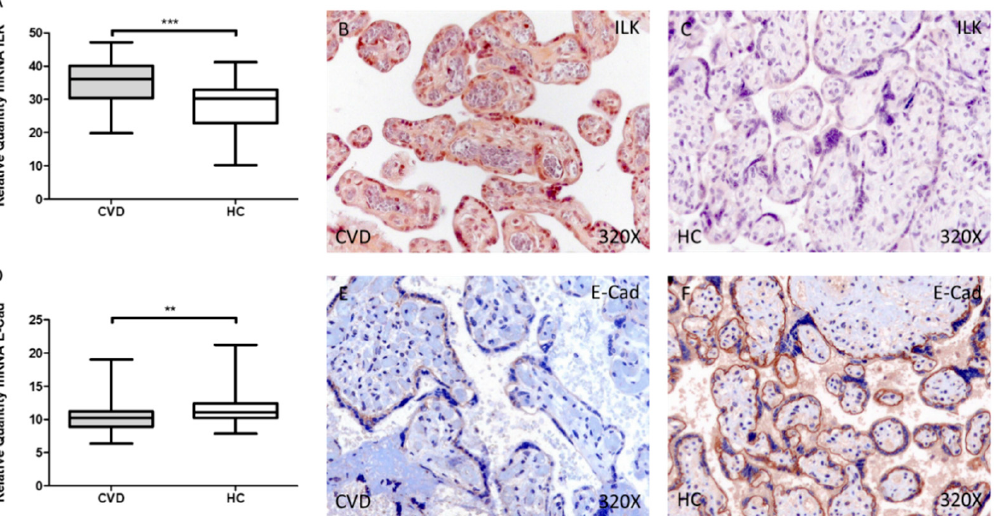
Figure 1. Levels of mRNA for ILK ( A ) and E-Cad ( D ) quantified by RT-qPCR, and histological imágenes for immunohistochemical techniques in the placental villi in of women with CVD during pregnancy and HC for ILK ( B , C ) and E-Cad ( E , F ). CVD = Chronic venous disease, HC = Healthy control. p < 0.01 (**), and p < 0.001 (***).